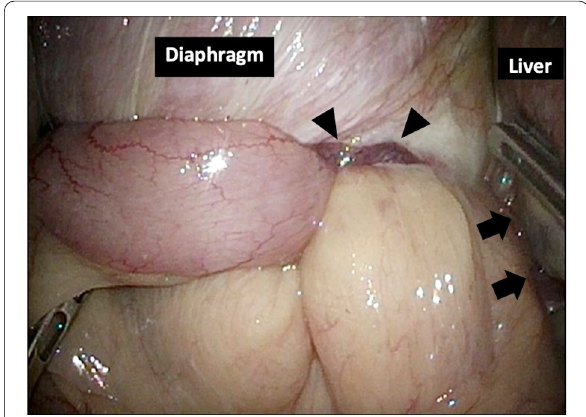
Fig. 3 Diaphragmatic hernia (DH). The small intestine is strangulated by the defect in the right side of the diaphragm (arrowheads). The location of the radiofrequency ablation-treated tumour coincides with the site of DH (arrows)